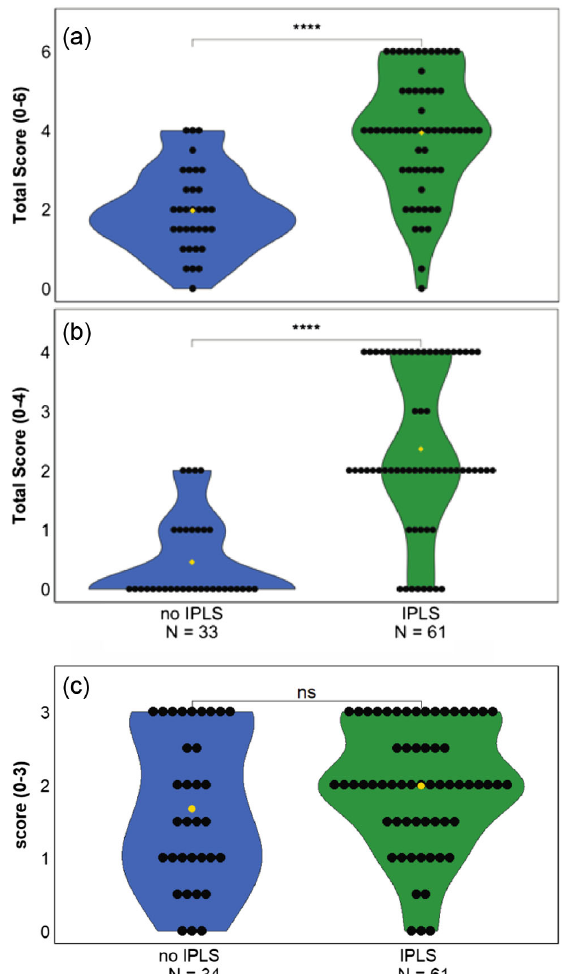
FIG. 6. (a),(b) Rubric scores on part (b) of the fluids task from non-IPLS students (blue envelope around black dots) and IPLS students (green envelope around black dots): (a) total score over all rubric elements, (b) score for justification and coordinating models. (c) For comparison, scores on part (c) of the thermo- dynamics task, which required some modeling as discussed in the text. One non-IPLS student skipped part (b) of the fluids task and completed the other parts, hence different N values. Each student ’ s score is represented by a black dot, and the median score is represented by a yellow dot; “ ns ” stands for not significant and means p > 0 . 05 ; **** indicates p < 0 . 0001 .